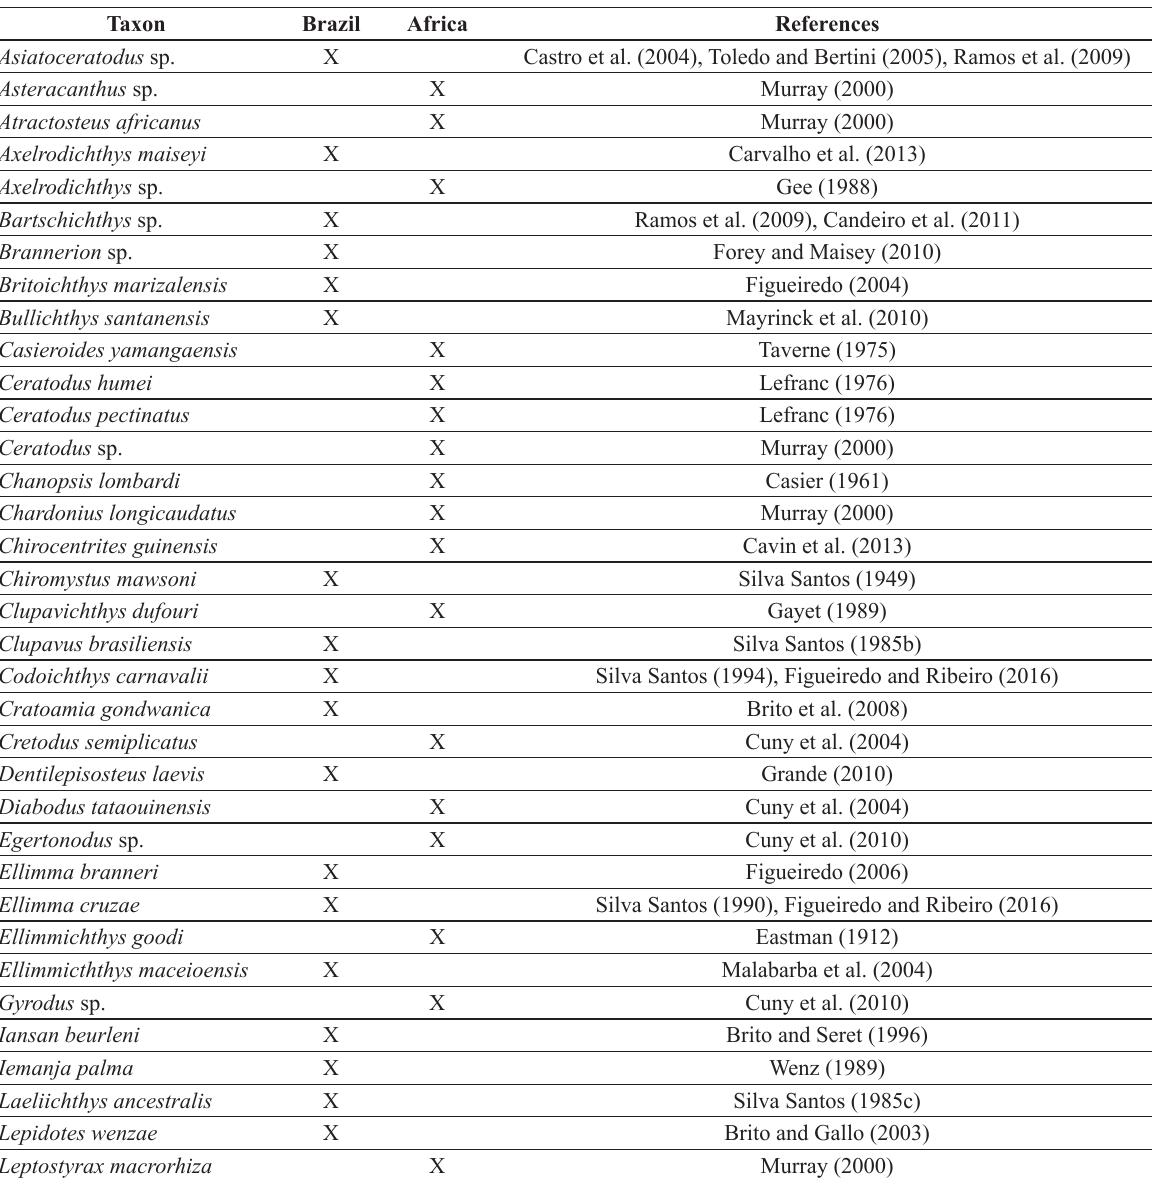
Occurrences excluded from the Individual